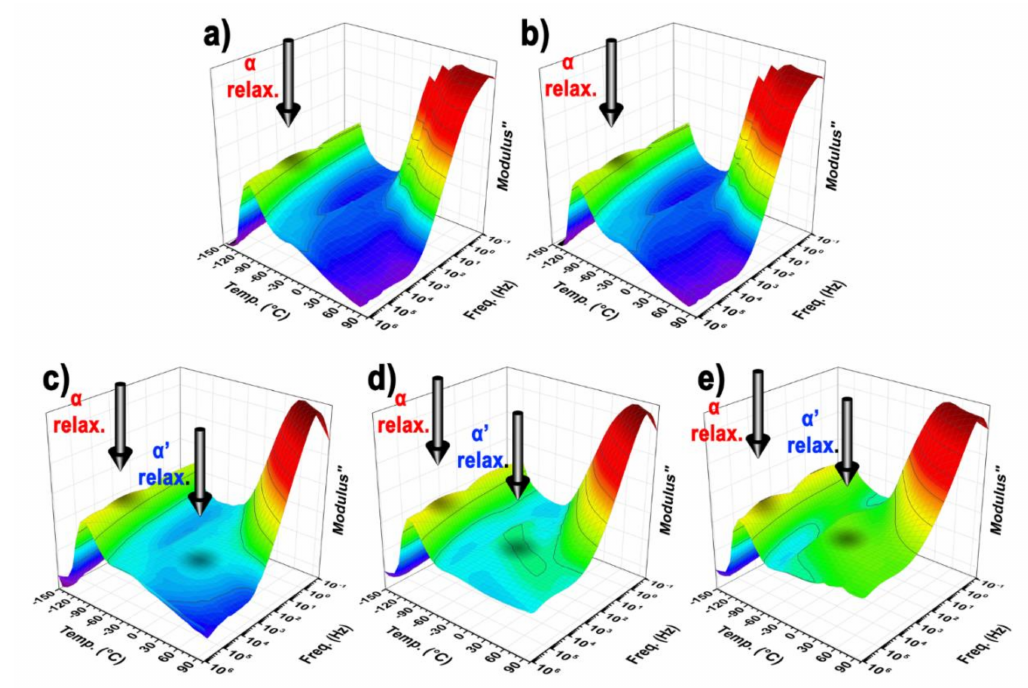
Figure 6. 3D plots of the dielectric properties of the neat PDMS matrix ( a ), and PDMS matrix filled with GO ( b ), 0.1 vol % GO–PHEMATMS ( c ), 0.5 vol % GO–PHEMATMS ( d ) and 1 vol % GO–PHEMATMS ( e ).